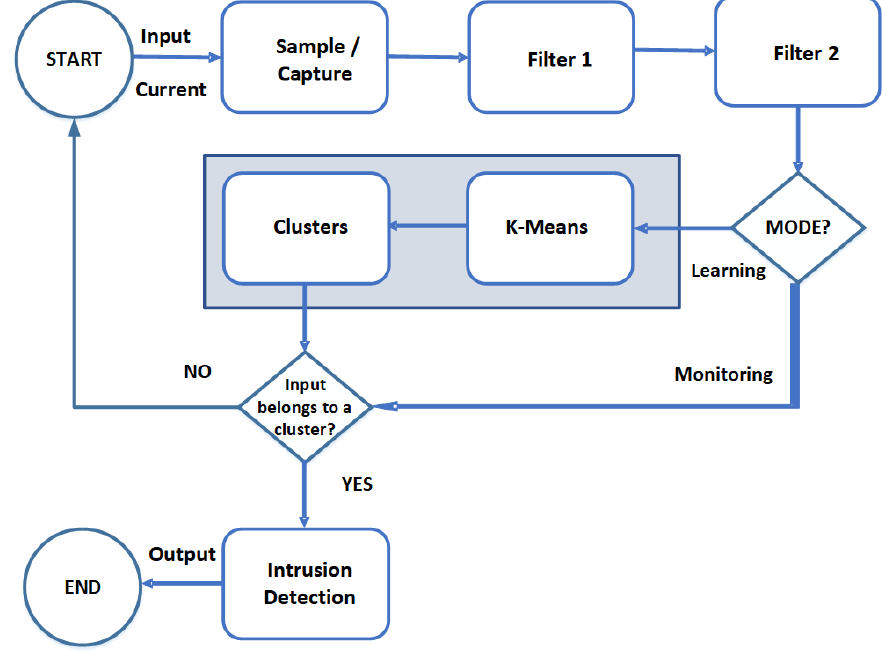
Figure 1. Workflow of process occurring in a smart shell